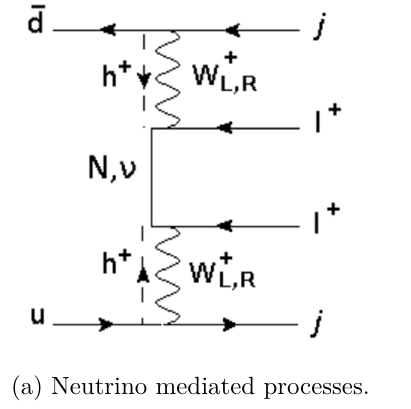
Figure 2. The s-channel diagrams leading to LSD + 2 jets signature. In each diagram, two lines with common endpoints represent two alternative possible particles, each with a different diagrammatic representation (names of particles with the same diagrammatic representation are separated by a comma). The generic h ± field represents possible singly charged Higgs eigenstates. 13